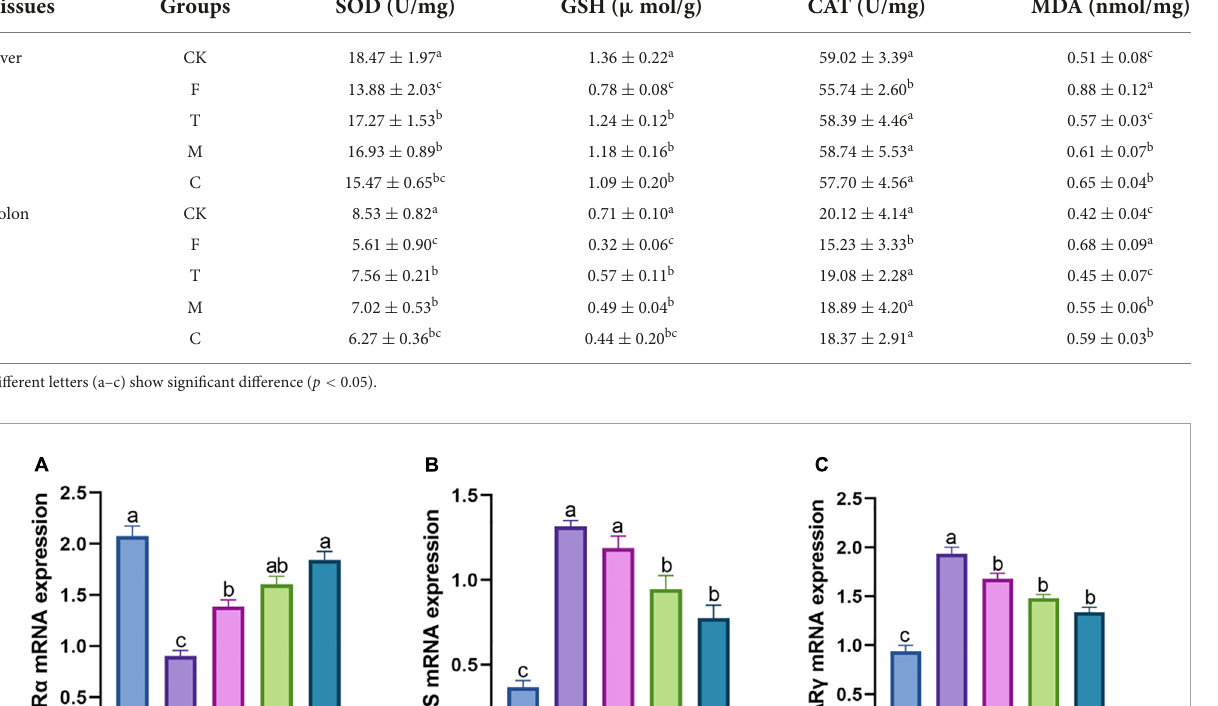
TABLE 3 Effects of green tea powder on the oxidative stress state associated indexes in the liver and colon of the high-fat diet induced obesity mice. Tissues Groups